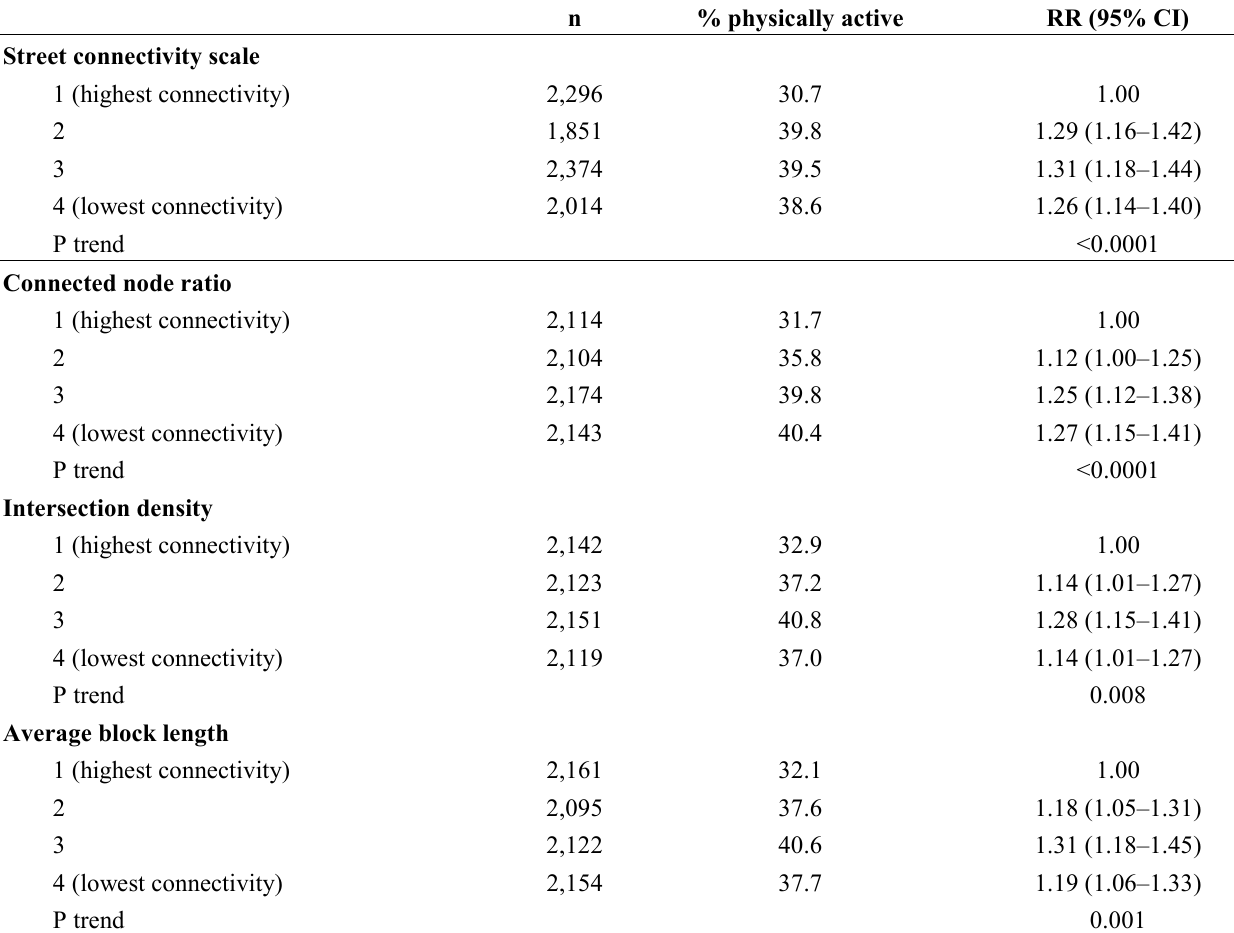
Table 3. Bivariate relations between street connectivity and physically activity (n =